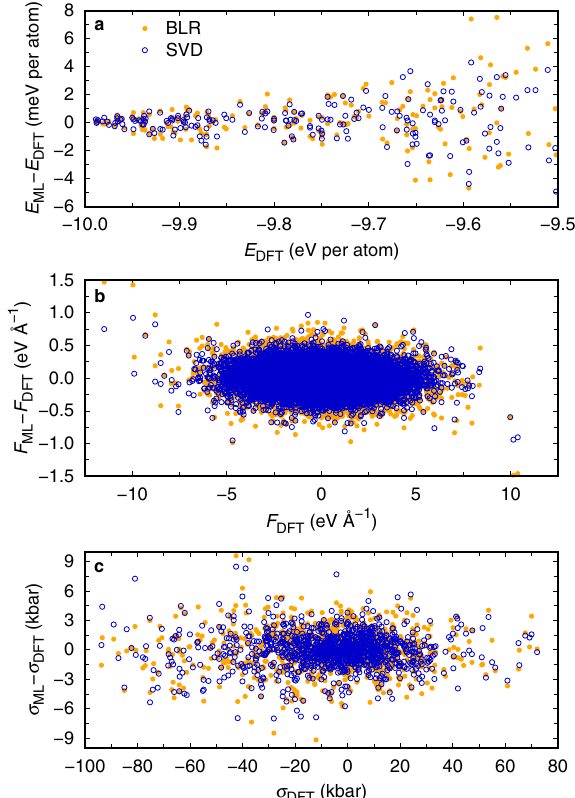
Fig. 2 Errors of the machine-learned force fi elds. Difference between the a energies, b atomic forces, and c stress components predicted by the MLFFs (in orange using BLR, in blue using SVD for the regression) and the DFT ones for the structures in the test dataset.